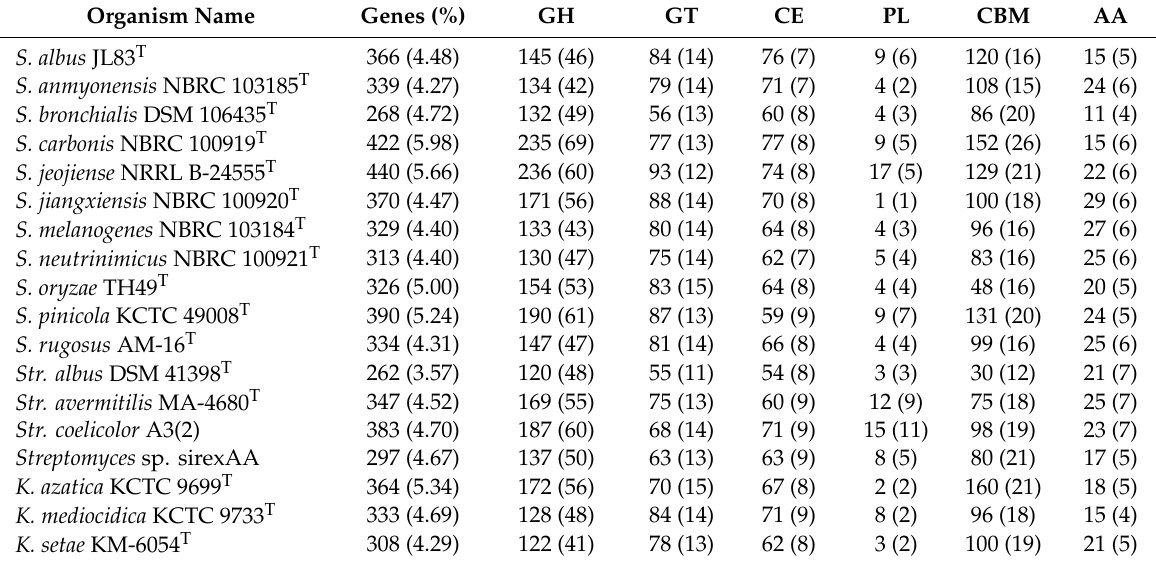
Table 4. Distribution of carbohydrate-active enzymes (CAZymes) and their various families in Streptacidiphilus and their comparison with representative Streptomyces and Kitasatospora species. For comparison, the CAZy profile of a well-known cellulose degrading Streptomyces sp. SirexAA strain is also shown. Values in parentheses (columns 3–8) represent di ff erent types of CAZy families. GH = glycoside hydrolase, GT = glycosyl transferase, CE = carbohydrate esterases, PL = polysaccharide lyases, CBM = carbohydrate-binding modules, AA = auxiliary